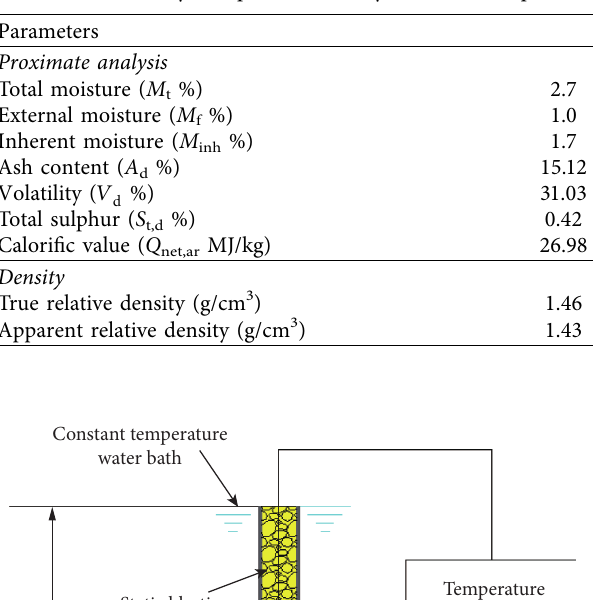
Table 2: Density and proximate analysis of coal